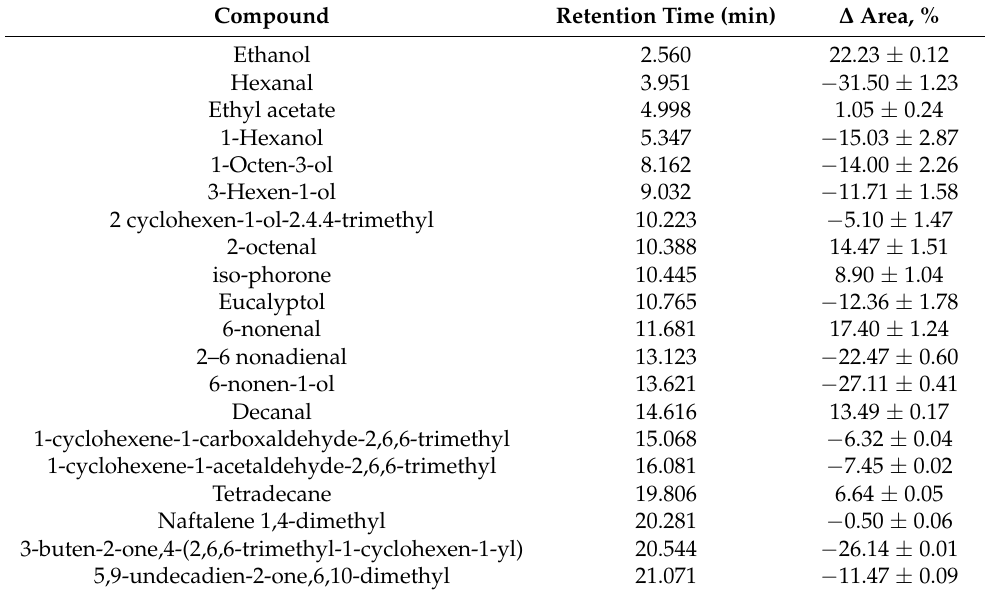
Table 5. Volatile flavor compounds identified in pumpkin samples in C-PLA film and percentage variation of peak area recorded at 11 days at 5 ◦